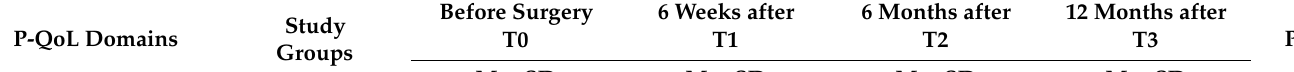
Table 2. Results of the Prolapse Quality of Life questionnaire